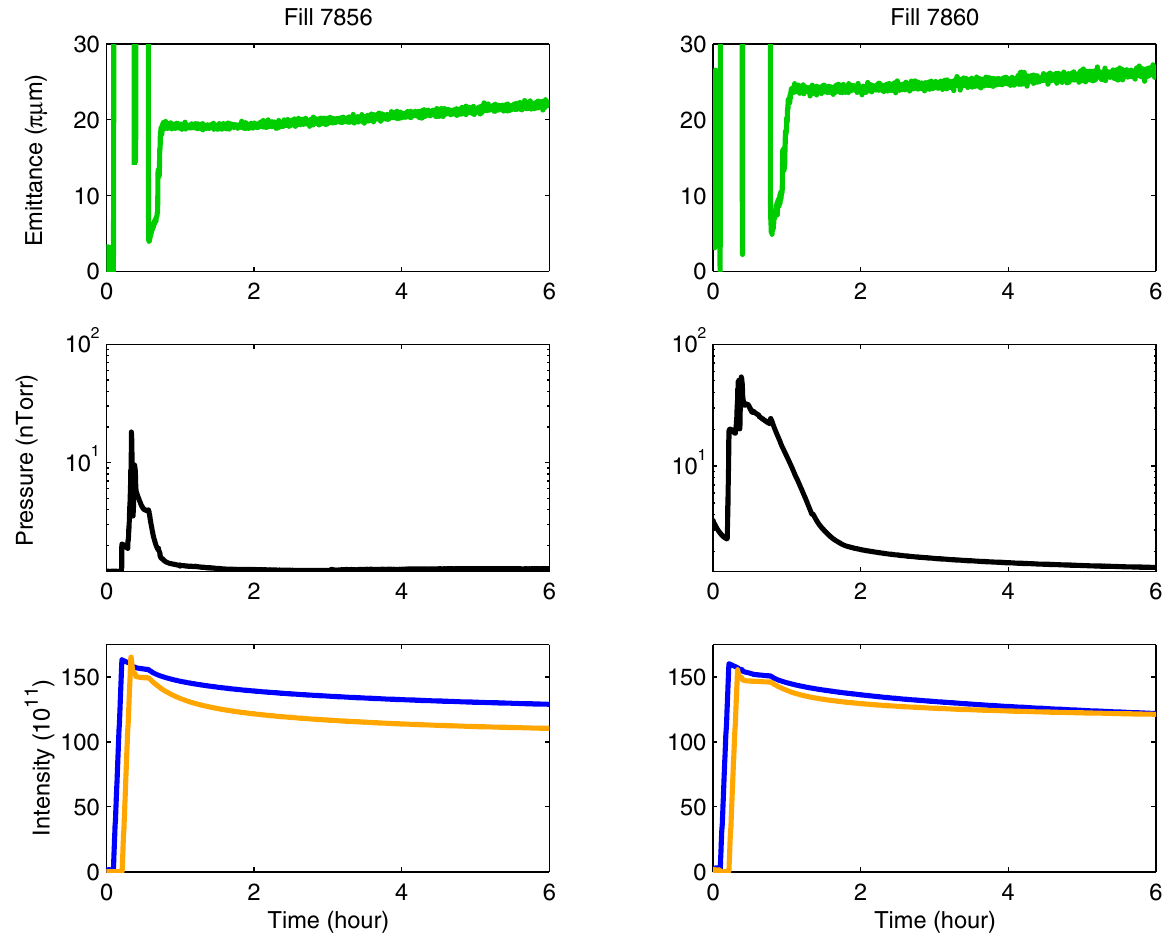
FIG. 9. (Color) The beam intensities, the average pressure rise in 4 worst long straight sections, and the 95% normalized emittance of the normal fill 7856, and the fill 7860 with the quadrupole mode pumping (shorter